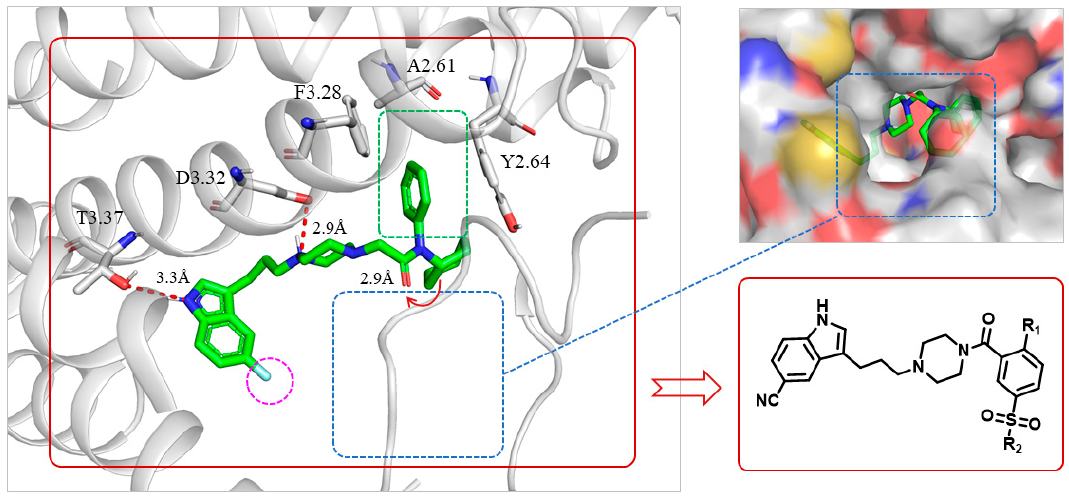
Figure 1. Predicted binding mode of FW01 (green sticks) with 5-HT 1A R (cartoon) and the design of indolealkylpiperazine derivatives. Ligands are shown as green sticks. The binding residues of 5-HT 1A R are shown in gray. Hydrogen bond interactions are represented as dotted red lines. 5-HT 1A R was obtained by homology modeling from the X-ray structure of 5-HT 1B R (PDB code: 6G79).